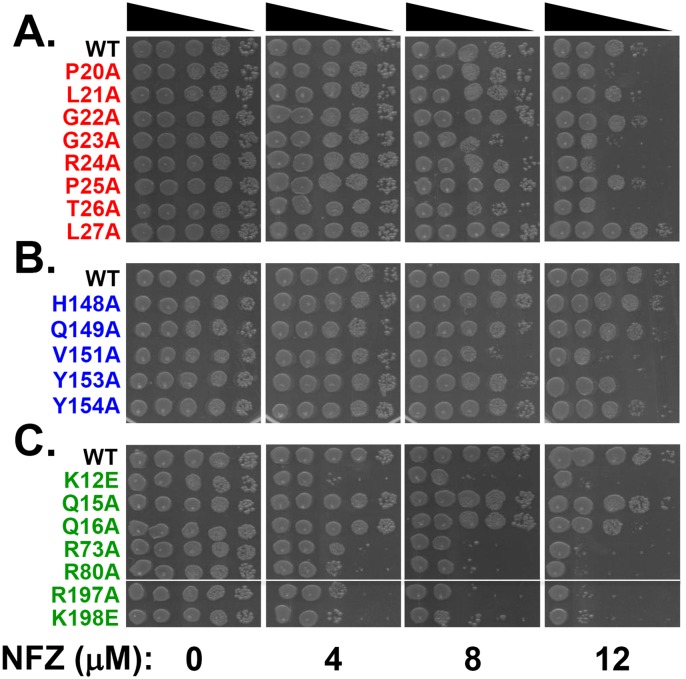
Sensitivity of mutant dnaN strains to NFZ.NFZ sensitivity of dnaN strains bearing mutations in (A) loop I (red), (B) loop II (blue) or (C) the central pore of the β clamp (green) was measured as described in Materials and Methods. Dimethylformamide (DMF) was used for the 0 NFZ control. This experiment was performed 4 times with 2 separate clones. Representative results shown.